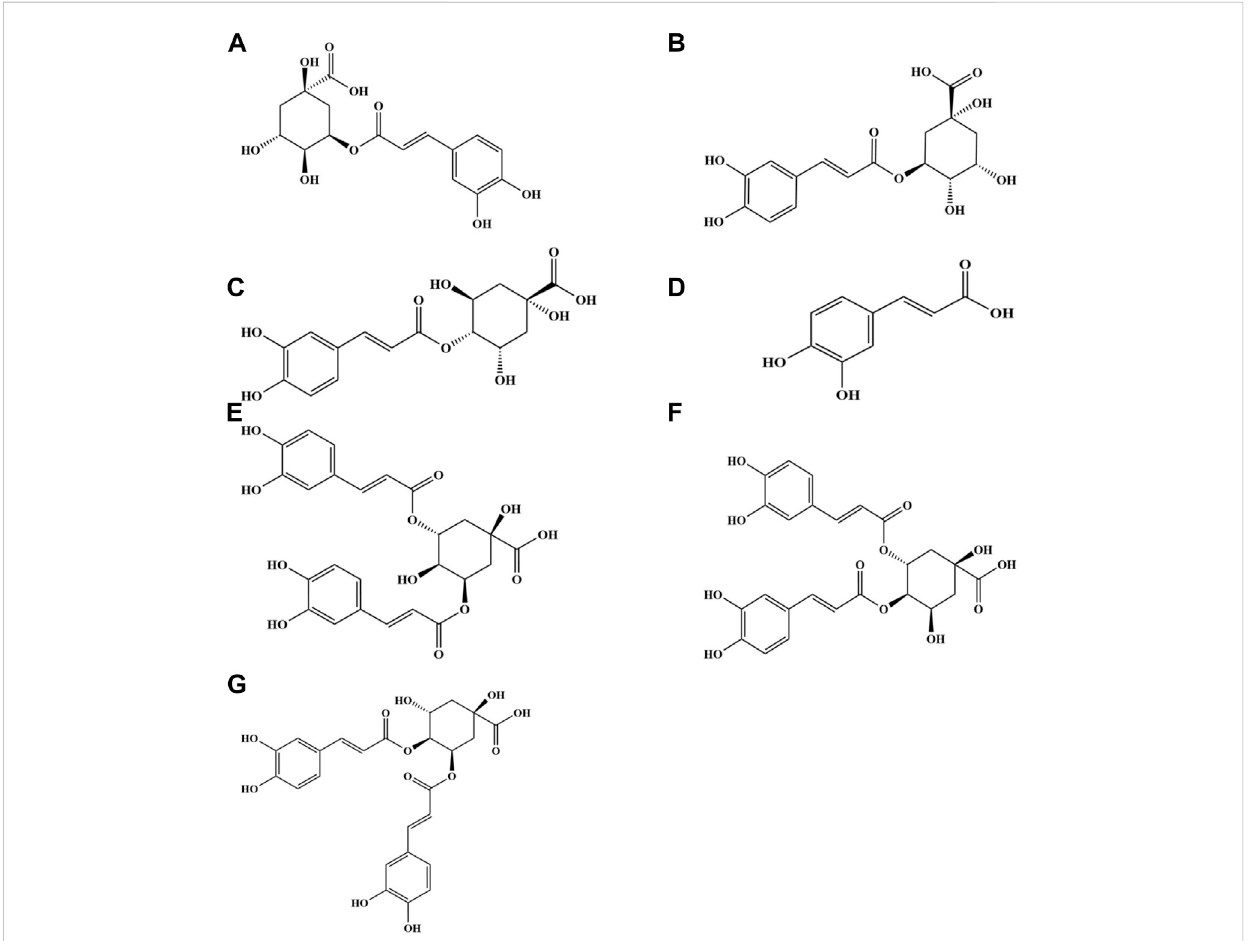
FIGURE 2 Chemical structure of the 7 phenolic acids in PS. (A) : 5-CQA; (B) : 3-CQA; (C) : 4-CQA; (D) : CA; (E) : 3,5-DiCQA; (F) : 3,4-DiCQA; (G) :